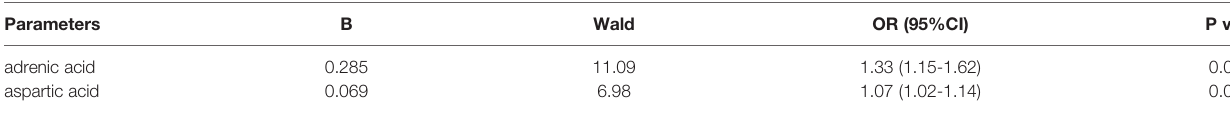
TABLE 2 | Final model of the multivariate logistic regression analysis.